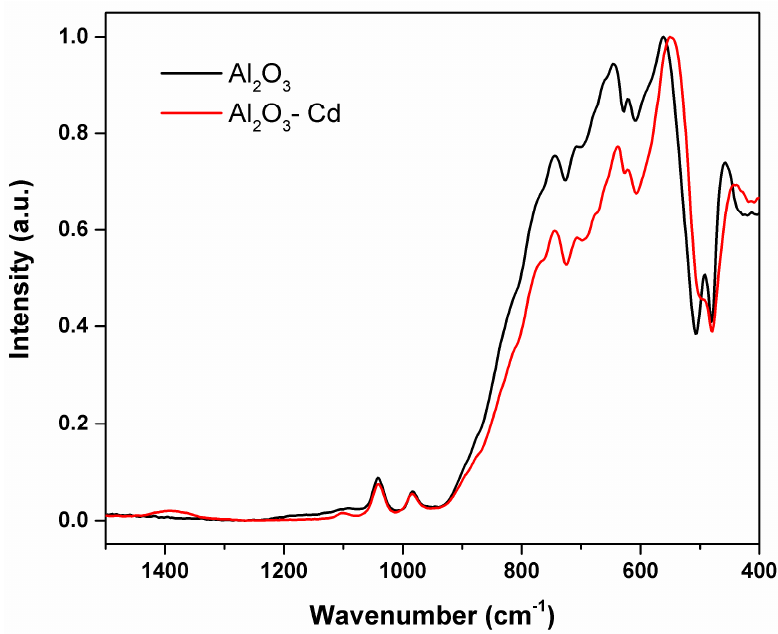
Figure 17. Infrared spectrum of S-Al 2 O 3 1600 °C and spheres after adsorbing cadmium.